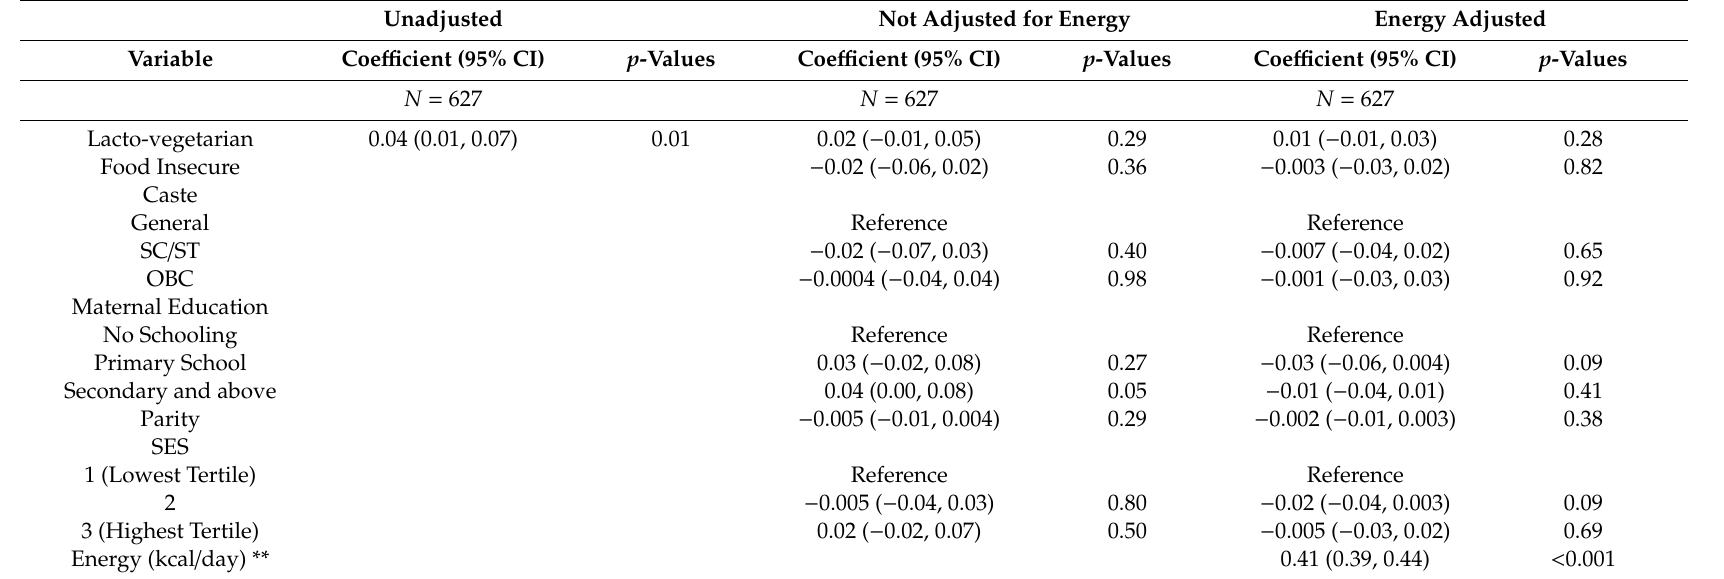
Table 4. Multivariable regression of determinants of mean probability of adequacy (MPA) * among pregnant women in Uttar Pradesh, India.